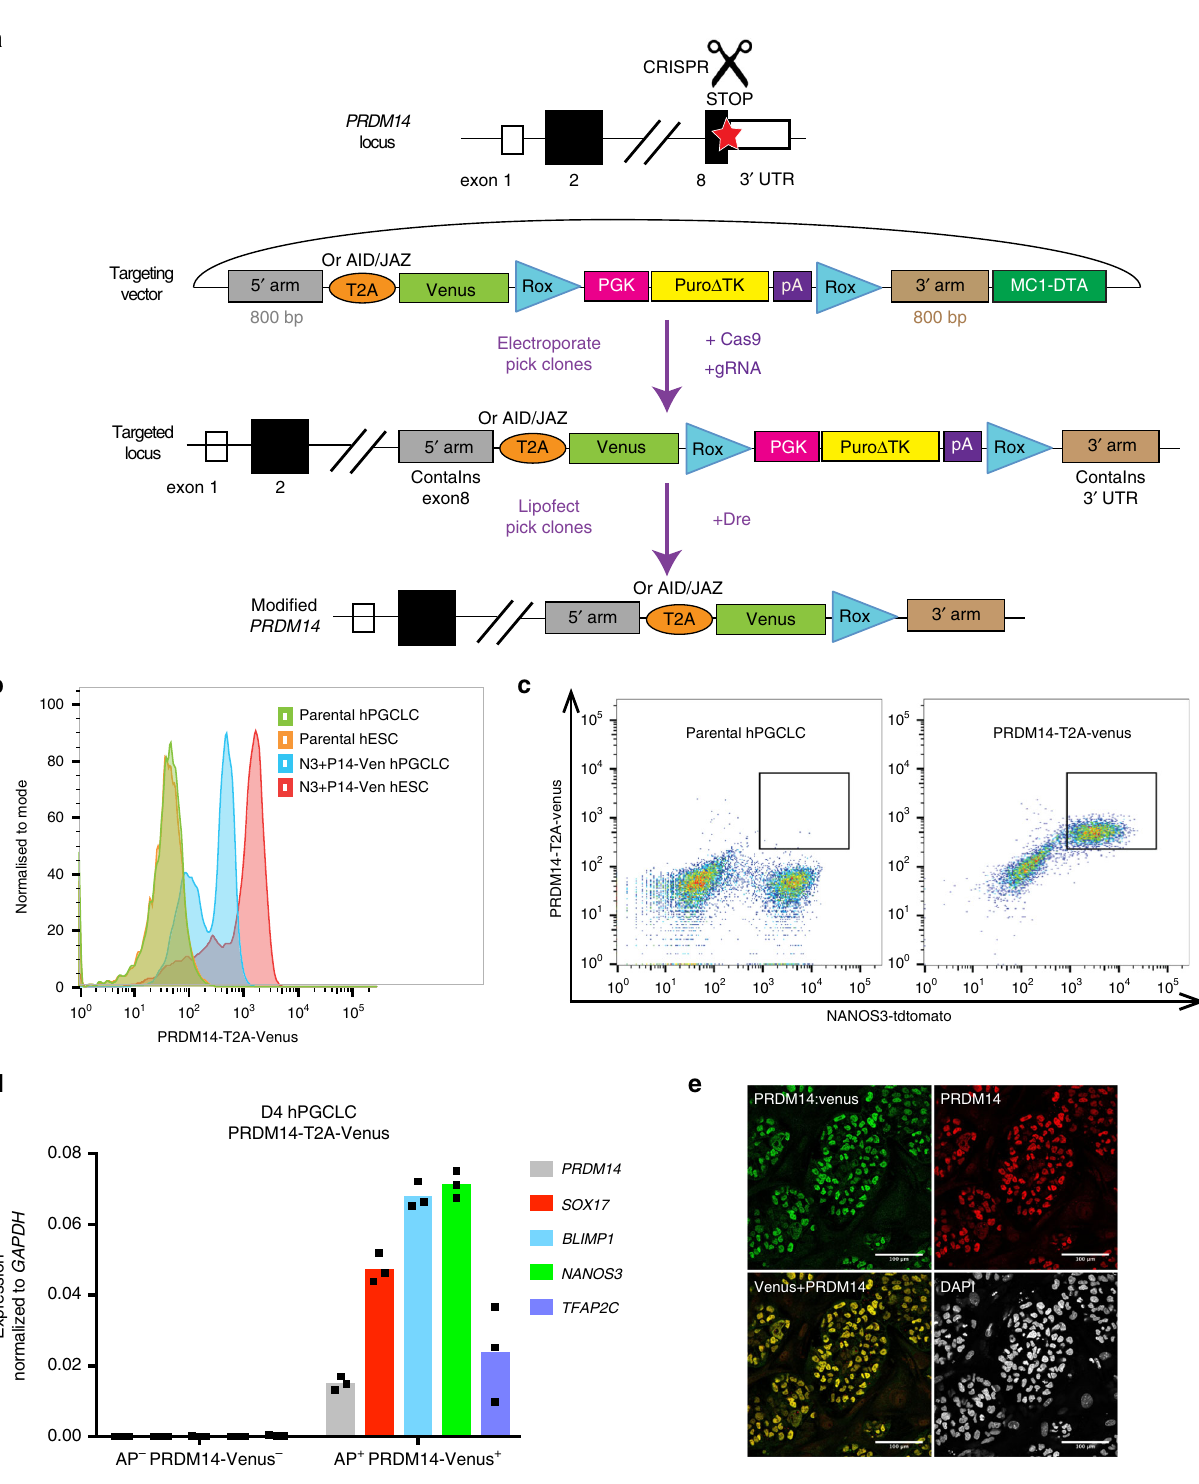
Fig. 1 PRDM14-Venus knock-in reporters allow PRDM14 detection in hESCs and hPGCLCs. a Scheme of CRISPR/Cas9-mediated PRDM14 locus targeting to generate T2A-Venus, AID-Venus or JAZ-Venus reporter versions. 5 ′ and 3 ′ arms — homology sequences, T2A — self-cleaving peptide, AID — auxin- inducible degron, Venus — fl uorescent gene, Rox — sequences for site-speci fi c recombination recognised by the Dre enzyme, PGK-Puro — puromycin resistance gene under the control of PGK promoter, Δ TK — truncated thymidine kinase gene, MC1-DTA — diphtheria toxin fragment A gene under the control of MC1 promoter. Also see Fig. 3a. b , c Flow cytometry analysis showing Venus fl uorescence in targeted hESCs and hPGCLCs compared with negative control. Note that Venus fl uorescence predominantly coincides with NANOS3-tdTomato signal, which marks hPGCLCs. d qPCR analysis on sorted PRDM14-T2A-Venus + AP + and double-negative cells from D4 EBs. Venus + AP + population shows speci fi c expression of germ cell markers. Data show results from three technical replicates (also see Source Data fi le). e IF analysis (representative of >10 experiments) of PRDM14-AID-Venus in competent hESCs showing co-localisation of PRDM14 and Venus fl uorescence. Nuclei were counterstained by DAPI. Scale bar is 100 μ